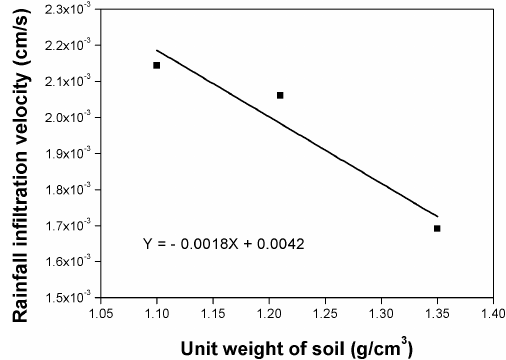
Figure 12. Rainfall infiltration velocity and unit weight of soils.